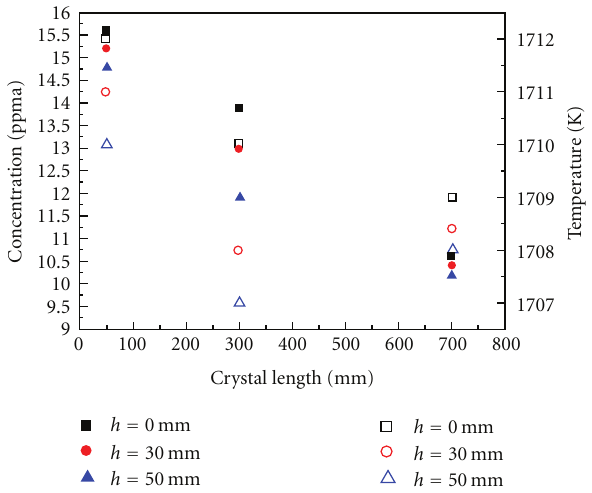
Figure 9: Average oxygen concentration at the crystal-melt inter- face and maximum temperature of crucible wall versus crystal length L